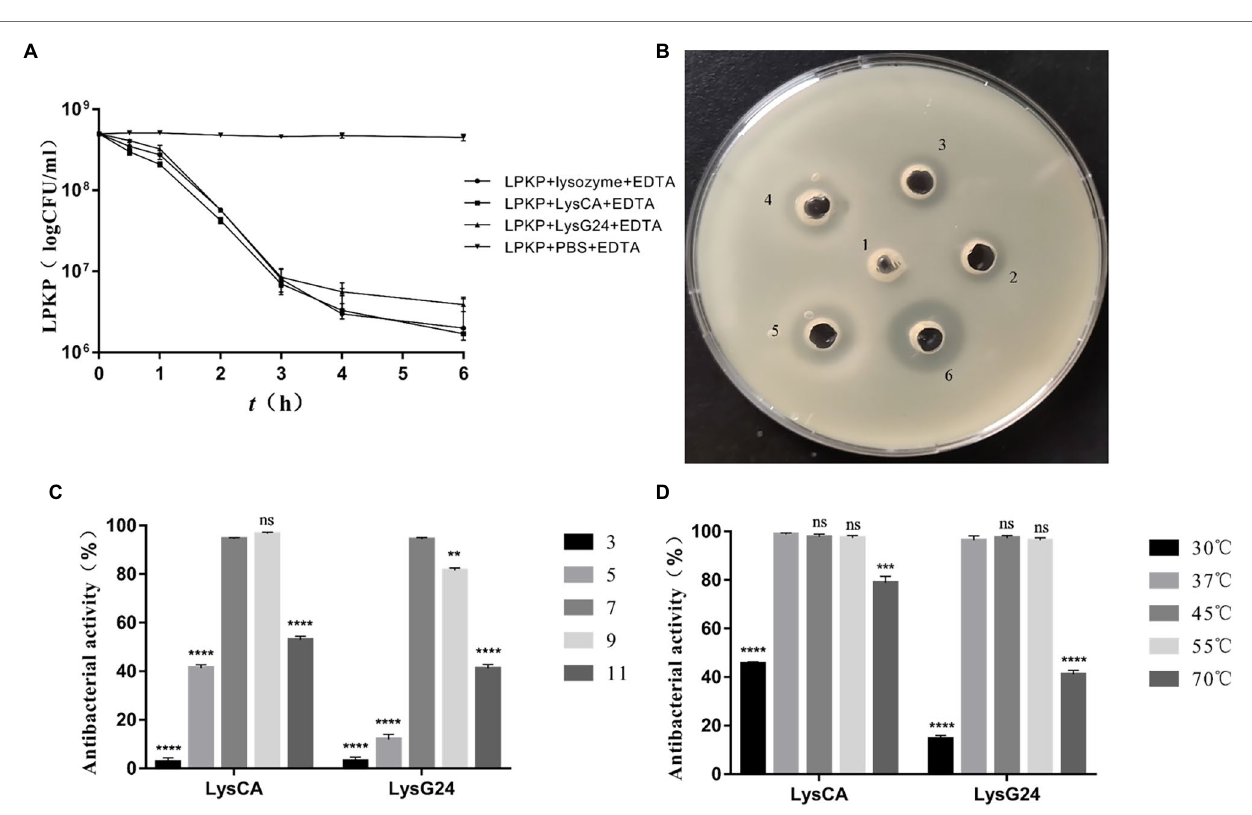
FIGURE 4 | In vitro antibacterial effect of LysG24 and LysCA. (A) Antibacterial results of plate counting method. (B) Antibacterial results of plate diffusion method. 1, PBS + EDTA; 2, LysG24; 3, LysCA; 4, Lysozyme + EDTA; 5, LysG24 + EDTA; and 6, LysCA + EDTA. (C) Antibacterial activity of recombinant protein at different pH values. (D) Antibacterial activity of recombinant protein at different temperatures (* p < 0.05; ** p < 0.01; *** p < 0.005; **** p < 0.001; ns, no significant difference compared with the data at pH=7 or 37 ° C).